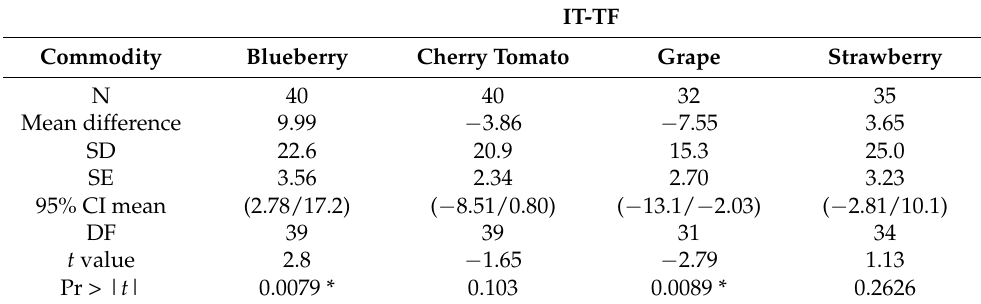
Table 3. Paired t -test comparing mean texture (IT-TF, firmness intensity) score between the images and real produce based on each commodity.